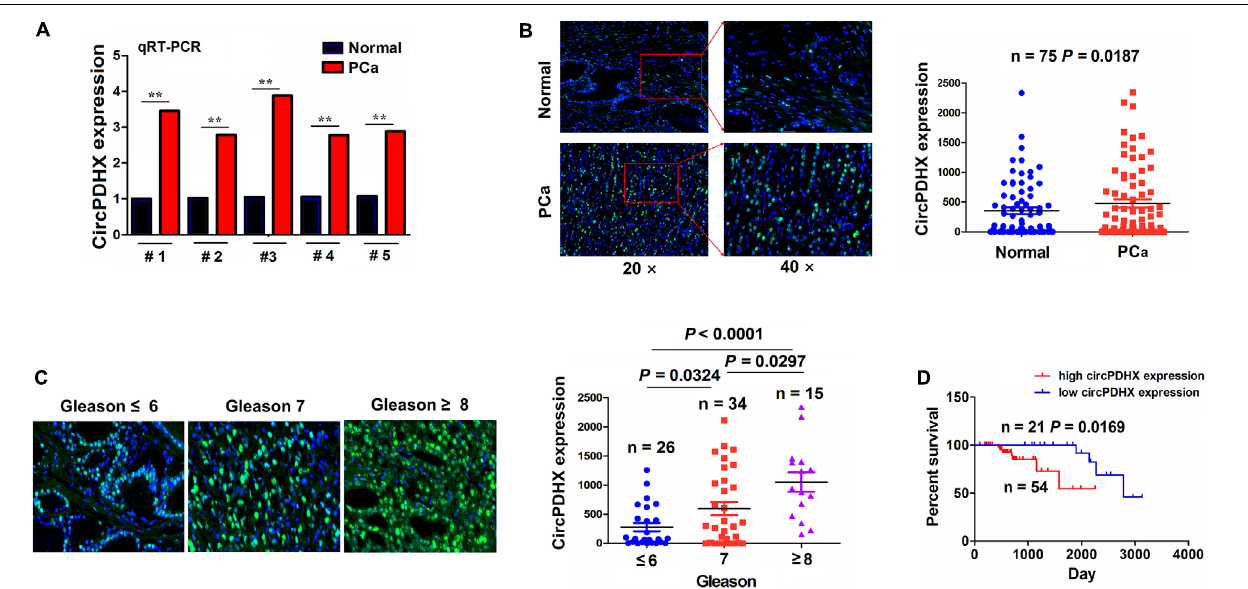
FIGURE 2 | Increased expression of circPDHX was associated with poor survival in patients with prostate cancer (PCa). (A) Quantitative real-time PCR (qRT-PCR) analysis of the expression levels of circPDHX in PCa and normal tissues ( n = 5). (B) Fluorescence in situ hybridization (FISH) analysis of the expression levels of circPDHX in pair-matched PCa tissue samples ( n = 75). (C) FISH analysis of the expression levels of circPDHX in PCa tissues with different Gleason scores. (D) Kaplan–Meier analysis of the association of high or low circPDHX expression with overall survival in patients with